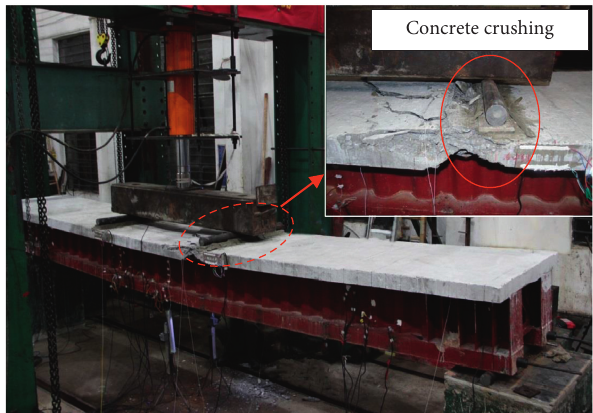
Figure 3: Failure mode of tested beam.